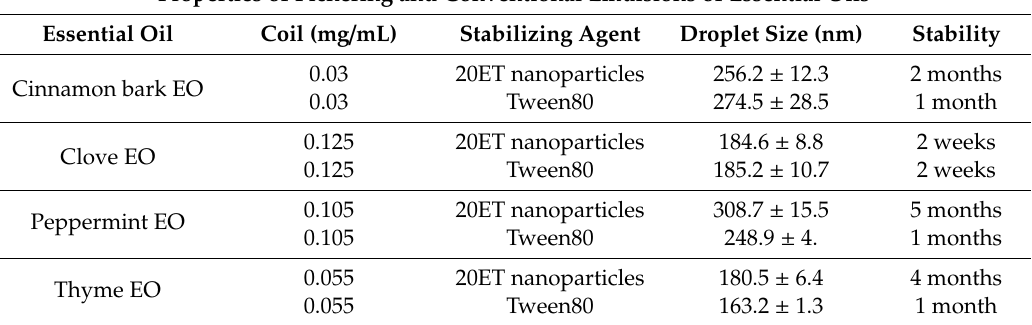
Table 2. Properties of Pickering and conventional emulsions of essential oils. Droplet sizes were determined with DLS measurements. Three parallel samples and measurements were